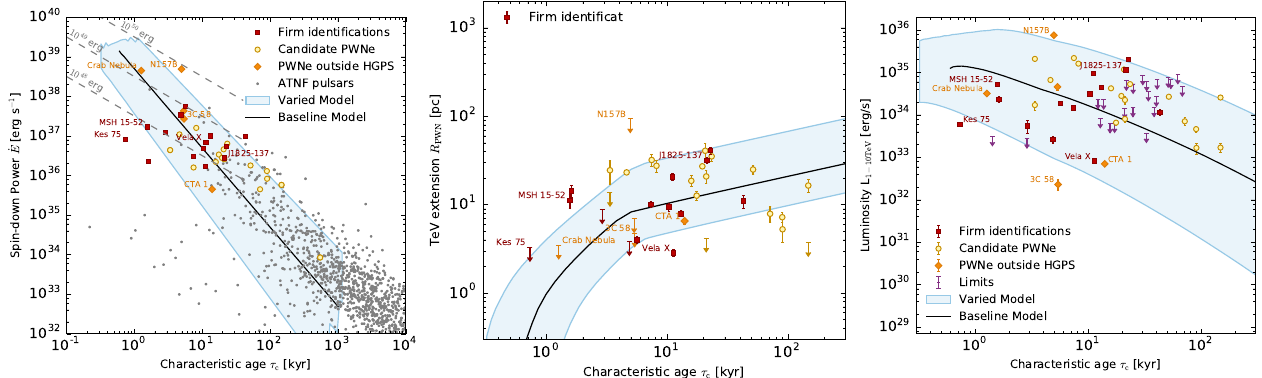
Figure 18. Results of PWN population study. ( Left ) Population of pulsars in the spin-down power ˙ E vs. characteristic age plane. Young and energetic pulsars, clustering at the top-left, are associated with plausible PWN candidates. ( Middle ) PWN extension evolution with time. ( Right ) Evolution of the PWN TeV luminosity with characteristic age. Reproduced from